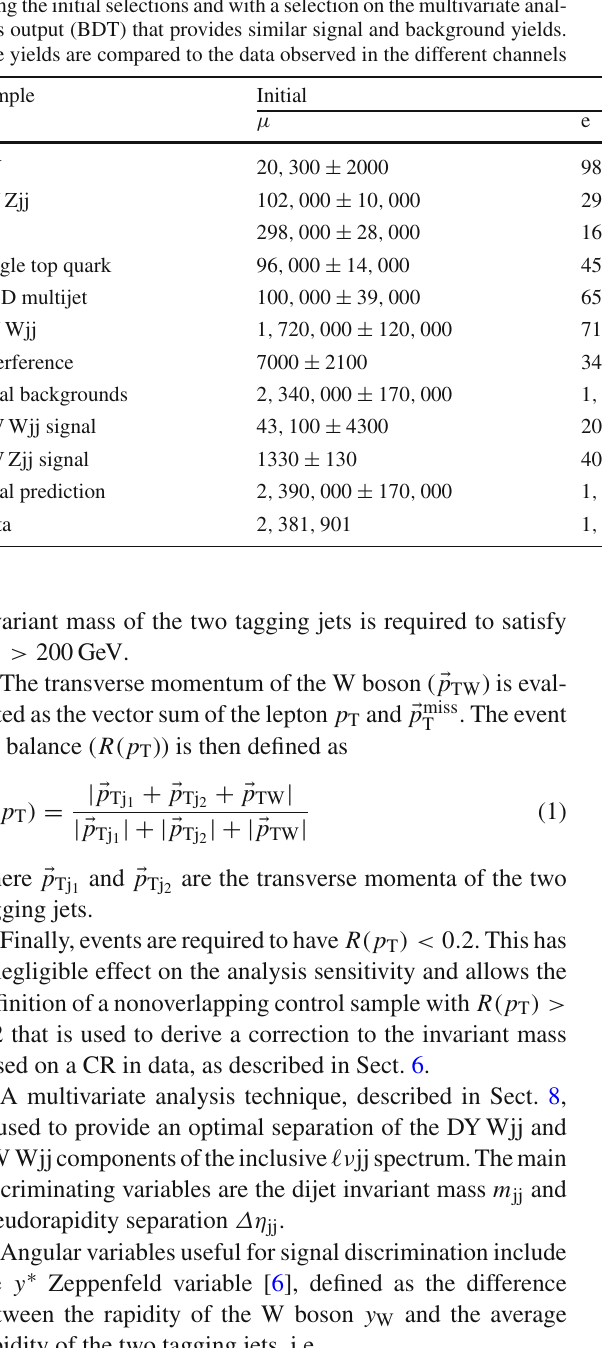
and categories. The total uncertainties quoted for signal, DY Wjj and diboson backgrounds, and processes with top quarks (t ¯ t and single top quarks) include the systematic